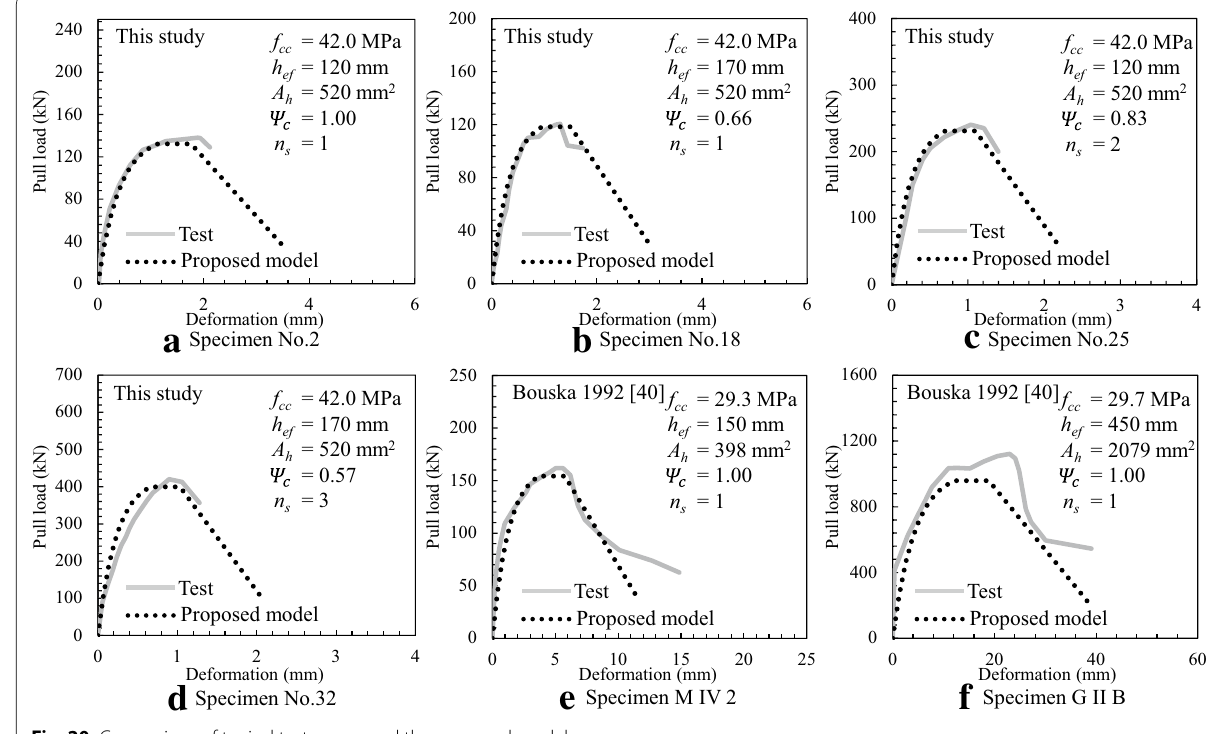
Fig. 20 Comparison of typical test curves and the proposed model.